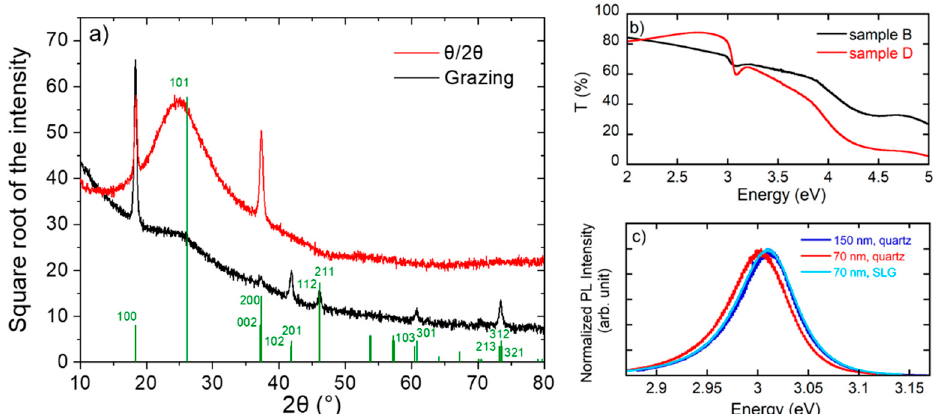
Figure 2. ( a ) XRD spectra of sample B in θ /2 θ (red line) and grazing angle incidence (black line) configuration. The bars mark positions of the identified tetragonal phase. ( b ) Transmittance spectra of samples B (in black) and D (in red) at room temperature. ( c ) Normalized macro-PL spectra at room temperature comparing samples differing in thickness and substrate.